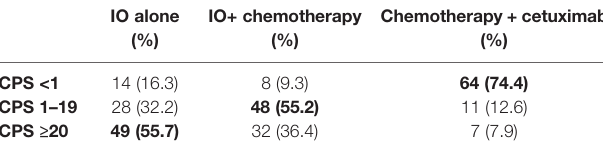
TABLE 4 | Clinical Case 2 — Preferred therapy according to CPS value.